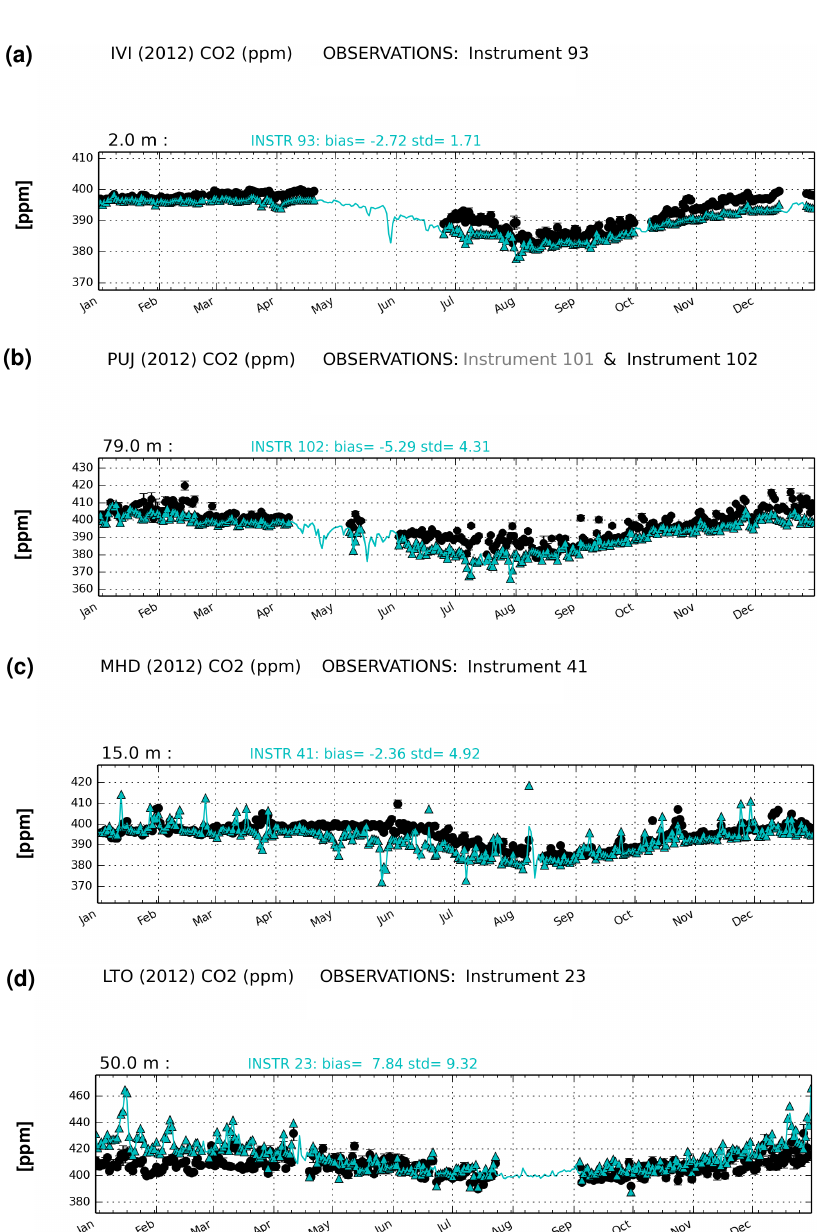
Figure 6. Daily mean dry molar fraction [ppm] of CO 2 at ICOS continuous surface sampling sites from measurements (black and grey circles represent two different instruments) and hindcasts collocated in time and space with observations (blue triangles) in 2012. The blue line depicts the daily mean values computed from the 3hourly model data. Any departures between the blue triangles and the blue line indicate that the observations are not able to sample the true daily mean. Error bars indicate the uncertainty associated with observations. The bias and standard deviation of the CO 2 hindcast with respect to the observations are shown above the panels for the different instruments.